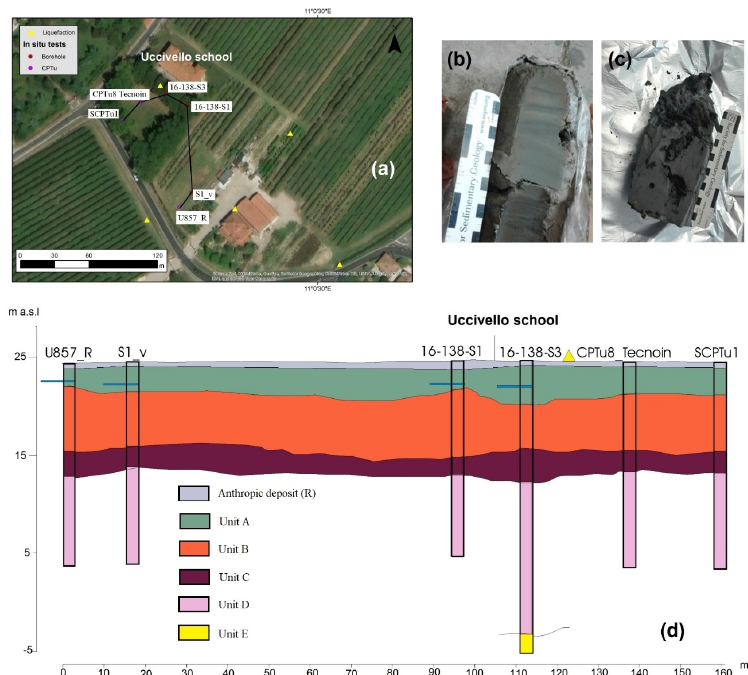
Figure 10. ( a ) Location of the geological cross-section (black line) near Uccivello school (about 2 km SW of Cavezzo urban center). ( b , c ) Sample from the borehole 16-138-S3 at depths of 5.50–6.5 and 10.85–11.50 m, showing the shallow sequence of thin levee layers and organic matter-rich clayey soils, respectively. ( d ) Simplified geological cross-section near Uccivello school. The liquefaction phenomena (yellow triangles) and groundwater level (blue lines) are also reported. In the area of the NE–SW fluvial ridge in the urban zone of Cavezzo (Figure 1), the analysis of the cone resistance (qc) and sleeve friction (fs) shows a high lateral and vertical lithological variability, due to the facies transition between channel and levee. The values of qc are not uniform for the shallow 5–10 m from the ground level, moving from the